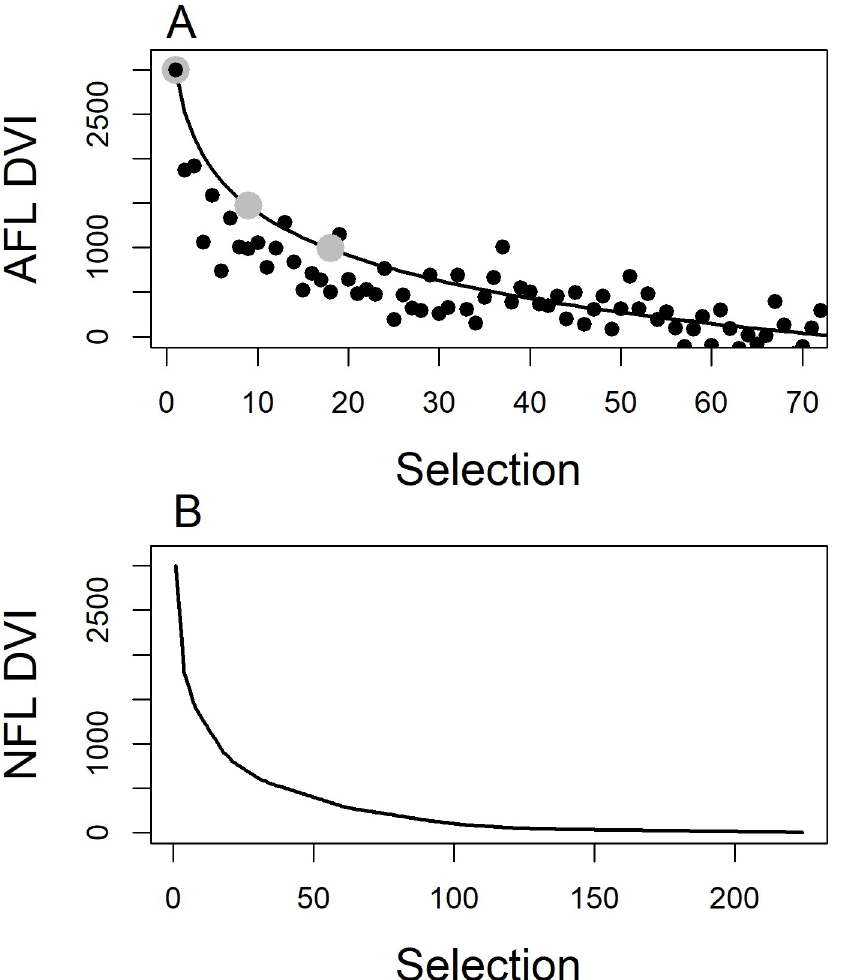
Fig 1. Draft Value Indices (DVI) by selection number. (A) The DVI (solid line) used by the Australian Football League (re-scaled to 3000 at selection number 1). Solid black points are salary data from which the DVI is derived. Solid grey points are draft values at selections 1, 9 and 18. (B) The DVI for the National Football League